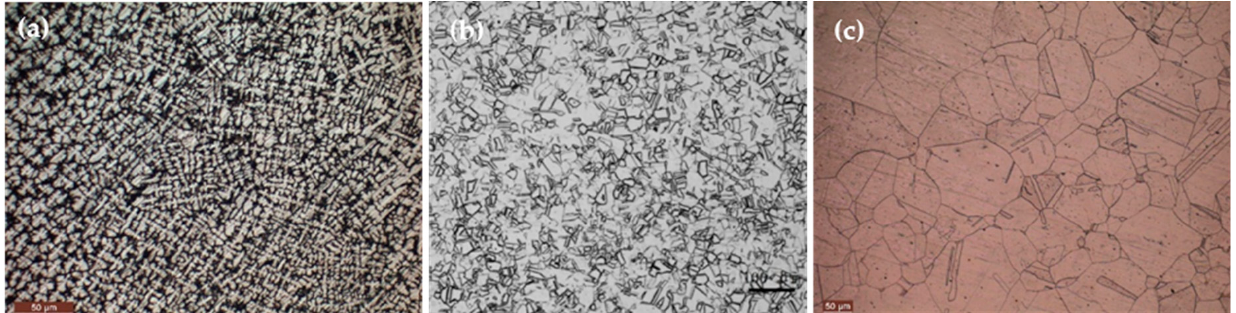
Figure 3. Metallographic photos of WZ and HAZ of 90-10 cupronickel: ( a ) WZ, ( b ) MZ, ( c ) HAZ.